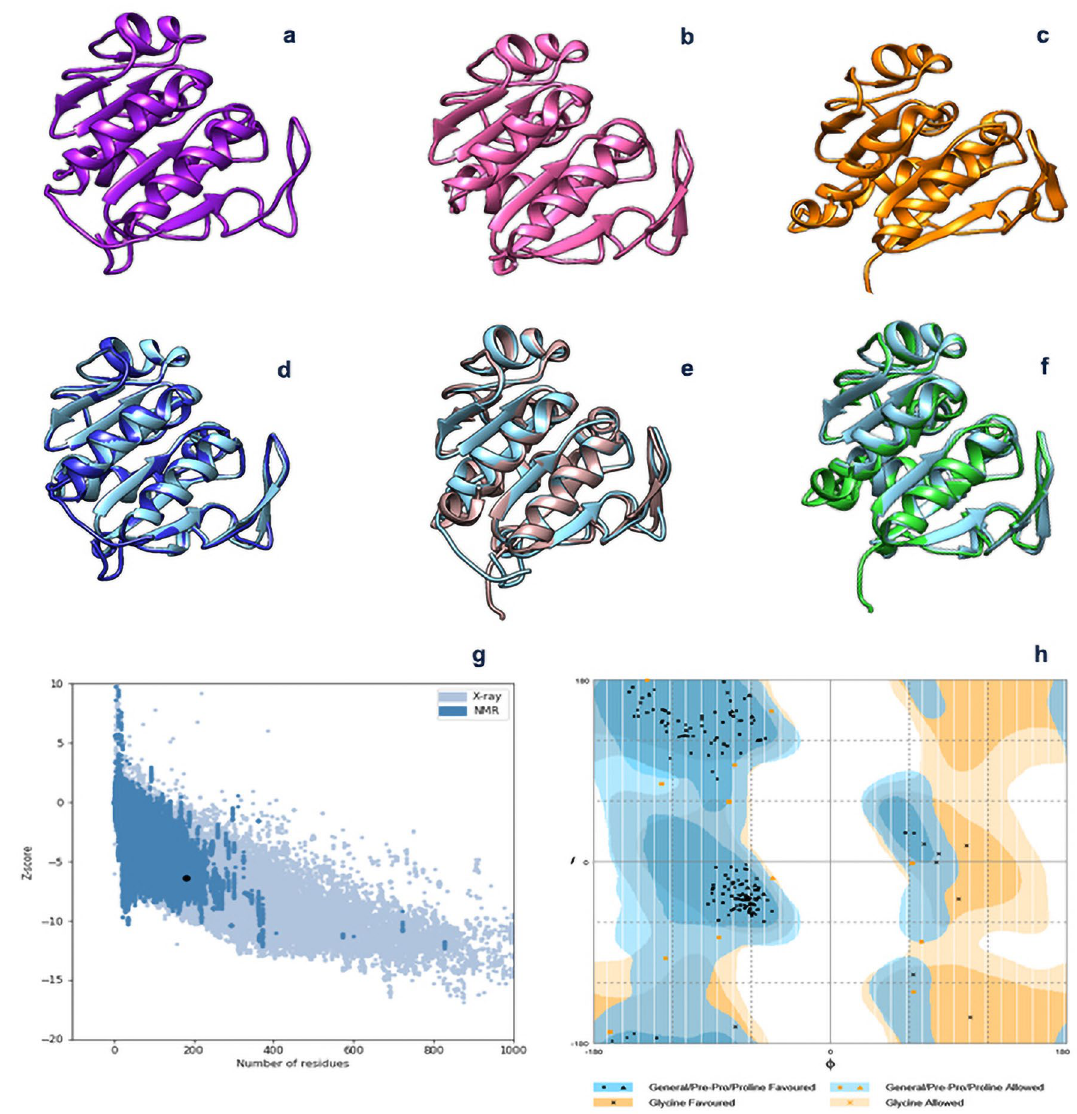
Figure 3. Predicted 3D structure of rEla ( a ) Modeller, ( b ) SWISS-MODEL and ( c ) i-Tasser. ( d – f ) superimpose and optimization of ( a , b ) structures, ( a , c ) models and ( b , c ) models with chimera 1.14. ( g ) z-score analysis for homology modelled rEla. The plot exhibited the validation of predicted structure. The black dot shows the similarity of model with X-ray and NMR structures. ( h ) Ramachandran plot revealed that 100% of residues were in favored and allowed